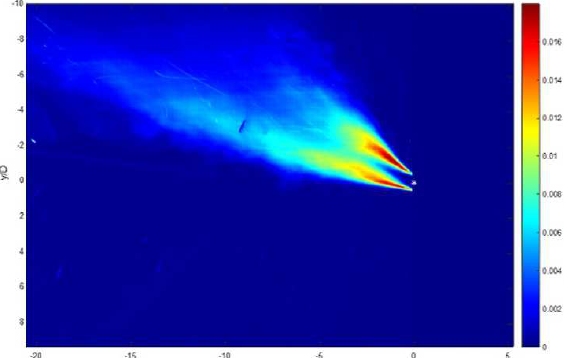
Fig. 10. Non-dimensional field of the variance of the concentration, non-dimensionalized with the square of the mean concentration measured at the outlet (highlighted by a yellow point), i.e. the initial jet concentration C 0 , for a jet with r =